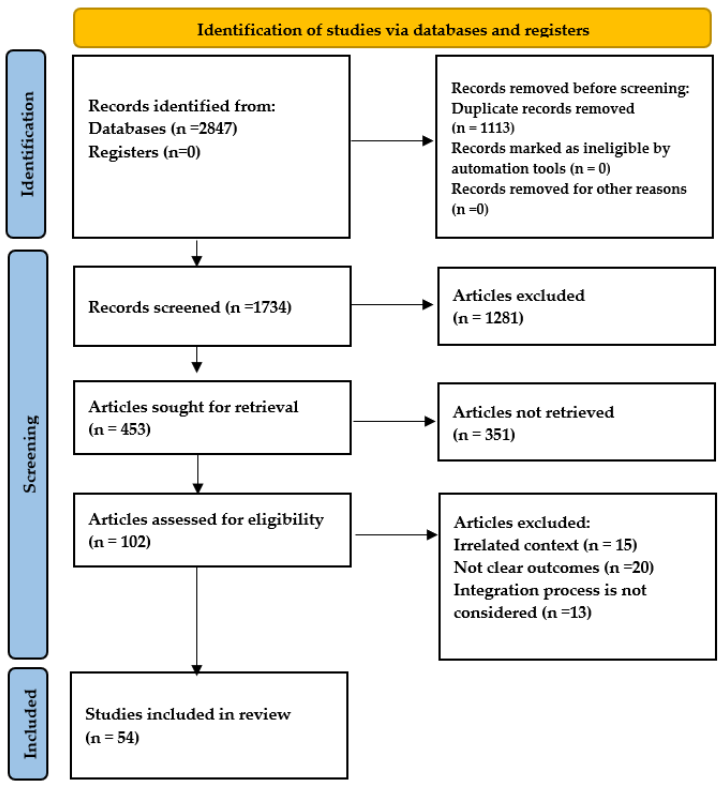
Figure 2. PRISMA 2020 flow diagram—Inclusion and exclusion criteria. Source: Authors’ elaboration.